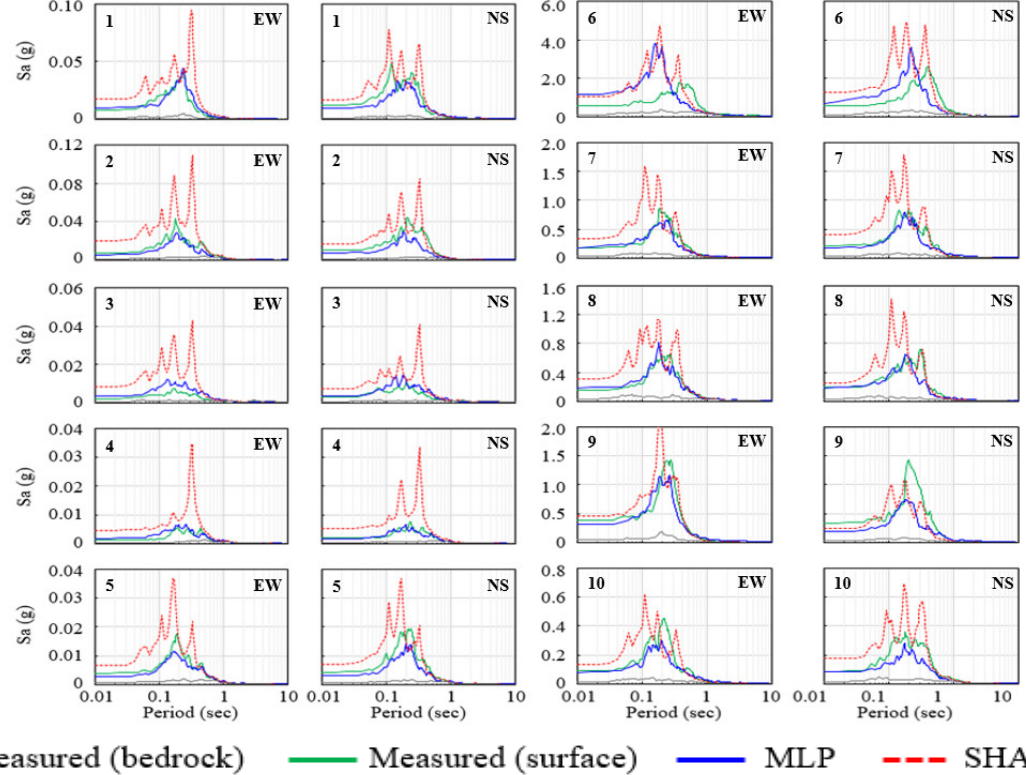
Figure 7. Measured, predicted, and computed response spectra at FKSH17 for east–west and north–south directions.